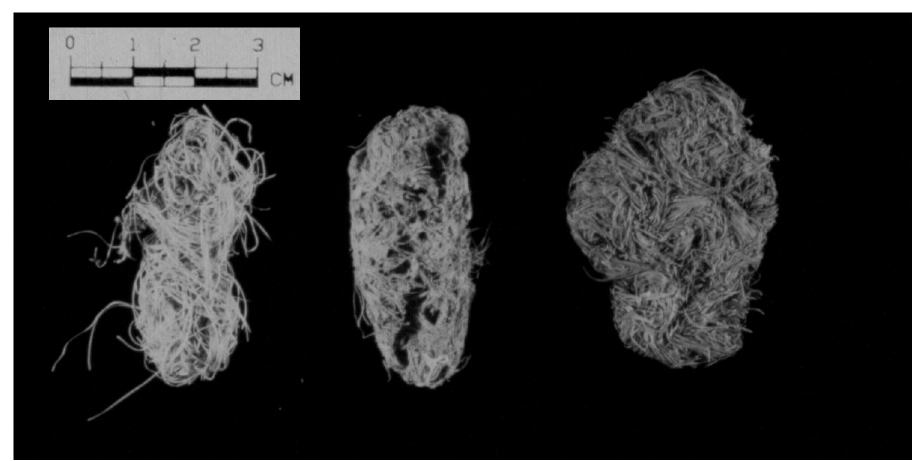
Fig 1. Example of an expectorated quid found in La Cueva de los Muertos Chiquitos, Durango Mexico. Based on the composition, it is easy to see how quid chewing (and swallowing) contributed to prehistoric high fiber diets and large amounts of phytoliths in the